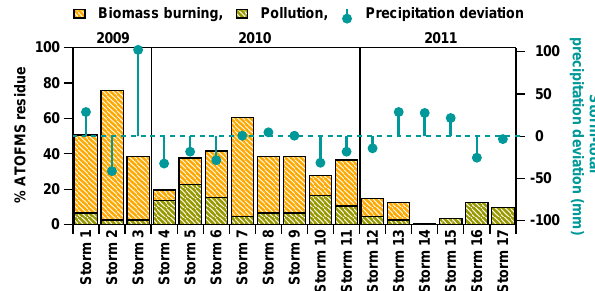
Figure 5. Summary of organic carbon precipitation residue com- position and storm-total precipitation deviation. Organic carbon residues are separated into those from biomass burning and those from local pollution. Storm-total precipitation deviation (mm) is calculated from all storms during CalWater (average: 55.46mm based on data from 43 days during ATOFMS sample collection time periods provided in Table 1). Positive (negative) deviations corre- spond to higher (lower) than average echo top